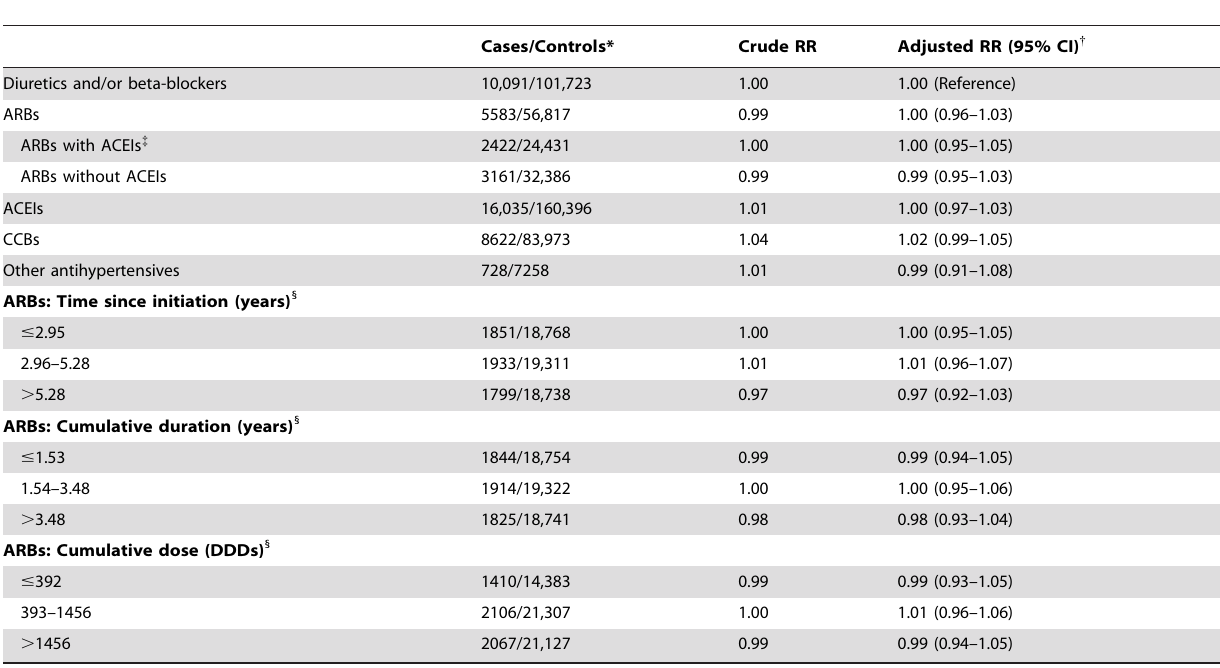
Table 2. Crude and adjusted rate ratios of cancer associated with antihypertensive agents relative to diuretic and/or beta-blocker